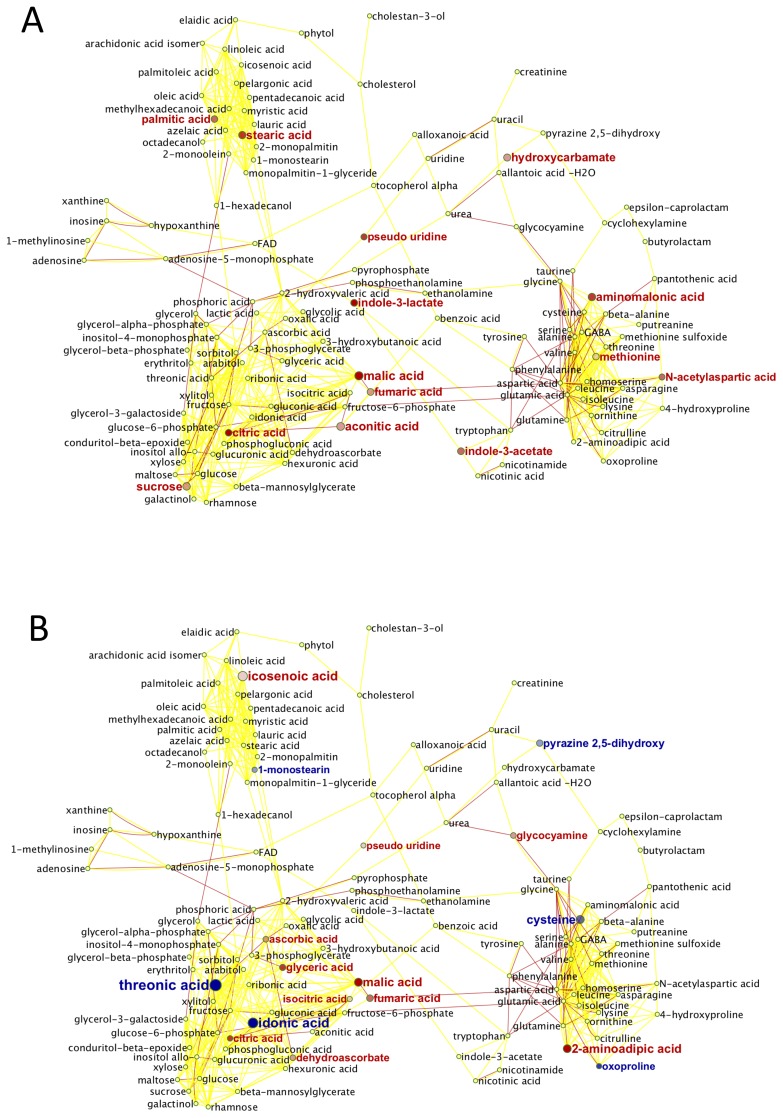
Lithium treatment effect on blood plasma metabolome. Metabolic network of wild-type and Sca1154Q/+ plasma phenotypes.
A. Wild-type mice. B. SCA1 knock-in mice. Red nodes: Increased metabolite levels under Lithium treatment; blue nodes: decreased levels. Node shades indicate ANOVA significance levels, node size reflect differences in magnitude of regulation. Red lines: reactant pair relationships obtained from the KEGG reaction pair database. Yellow solid lines: chemical similarity >0.5 Tanimoto score (Tanimoto scores range between 0 to 1, where 1 reflects identical structures). Yellow broken lines: chemically closest structure at <0.5 Tanimoto scores.